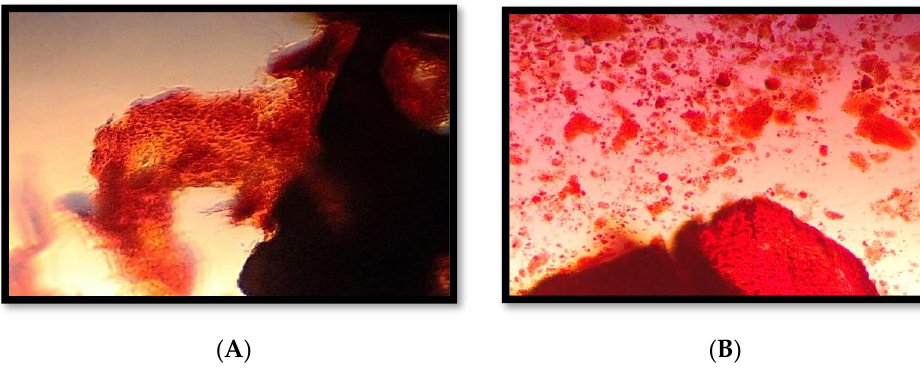
Figure 2. Alizarin Red S staining of mineralized calcium deposition. ( A ) 14 days of cultured PDLSCs with xenograft bone block in osteogenic growth media, ( B ) 21 days of cultured PDLSCs with xenograft bone block in osteogenic growth media.